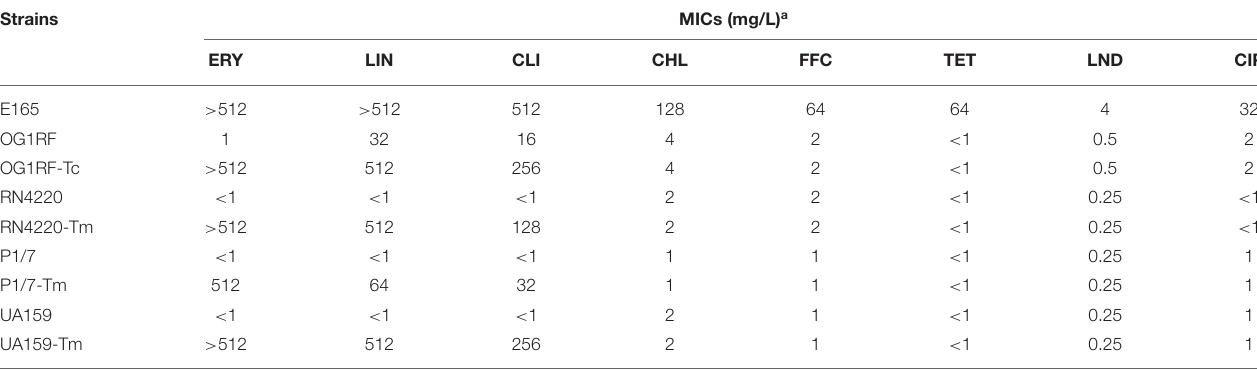
TABLE 2 | MICs of erm (T)-carrying E. faecalis E165, recipient strains E. faecalis OG1RF, S. aureus RN4220, S. suis P1/7, S. mutans UA159, and corresponding transconjugants/transformants.